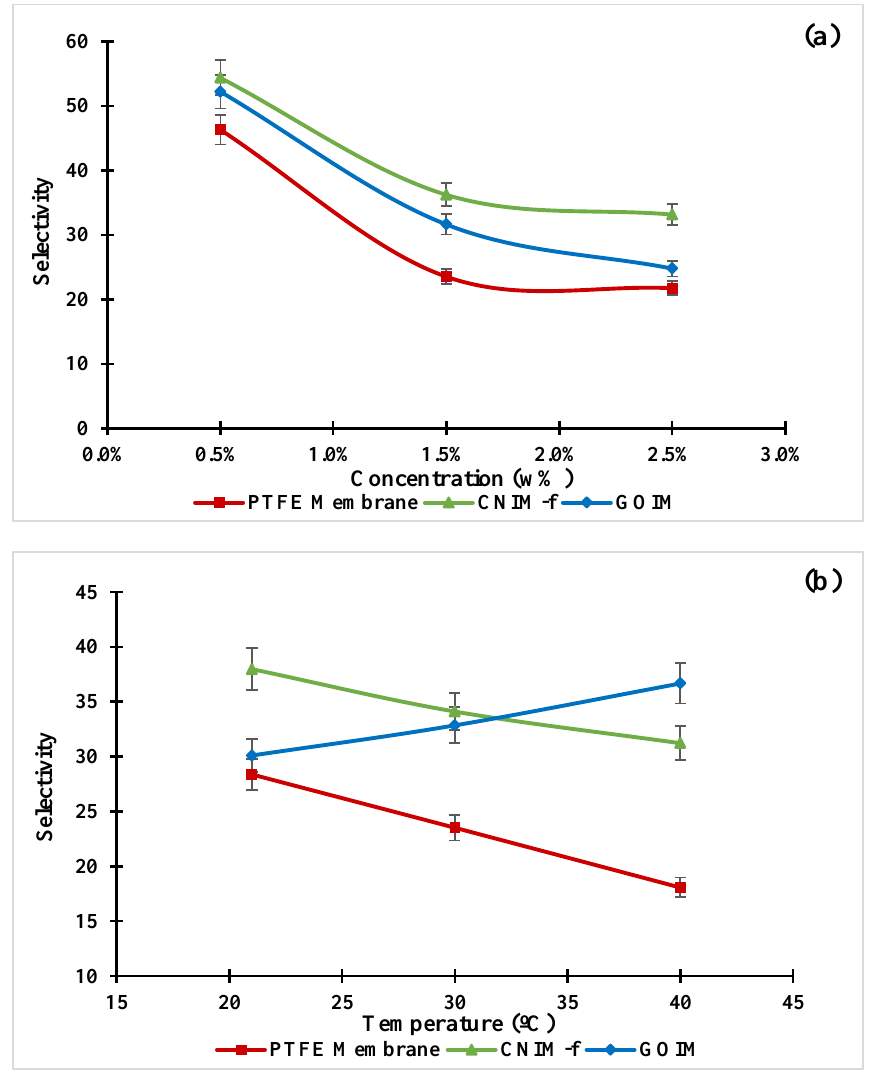
Figure 9. Effect of ( a ) feed concentration and ( b ) feed temperature on MTBE selectivity of membranes.